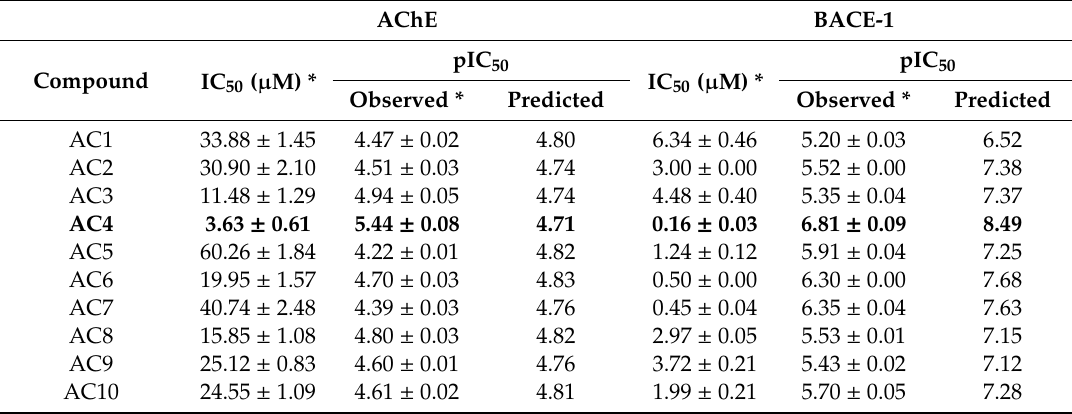
Table 1. Acetylcholinesterase (AChE) and beta-secretase (BACE-1) inhibitory activities of synthesized N -substituted-4-phenothiazine-chalcones.